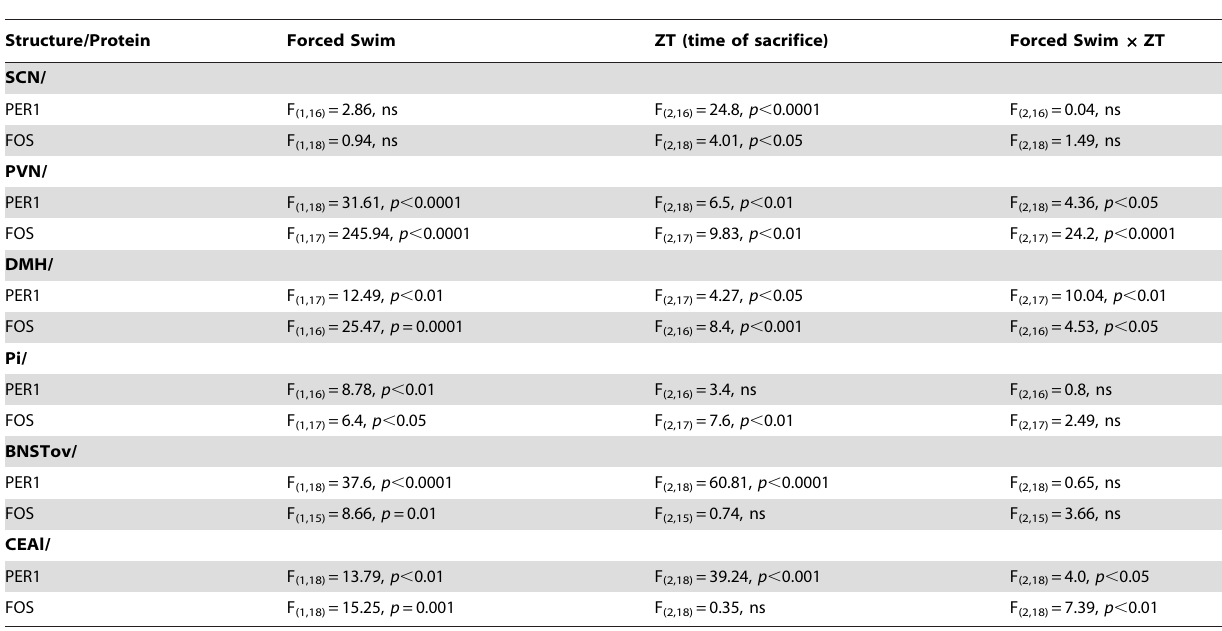
Table 2. Statistical analysis (ANOVA) of the effect of acute forced swim stress on PER1 and FOS expression in hypothalamic and limbic brain